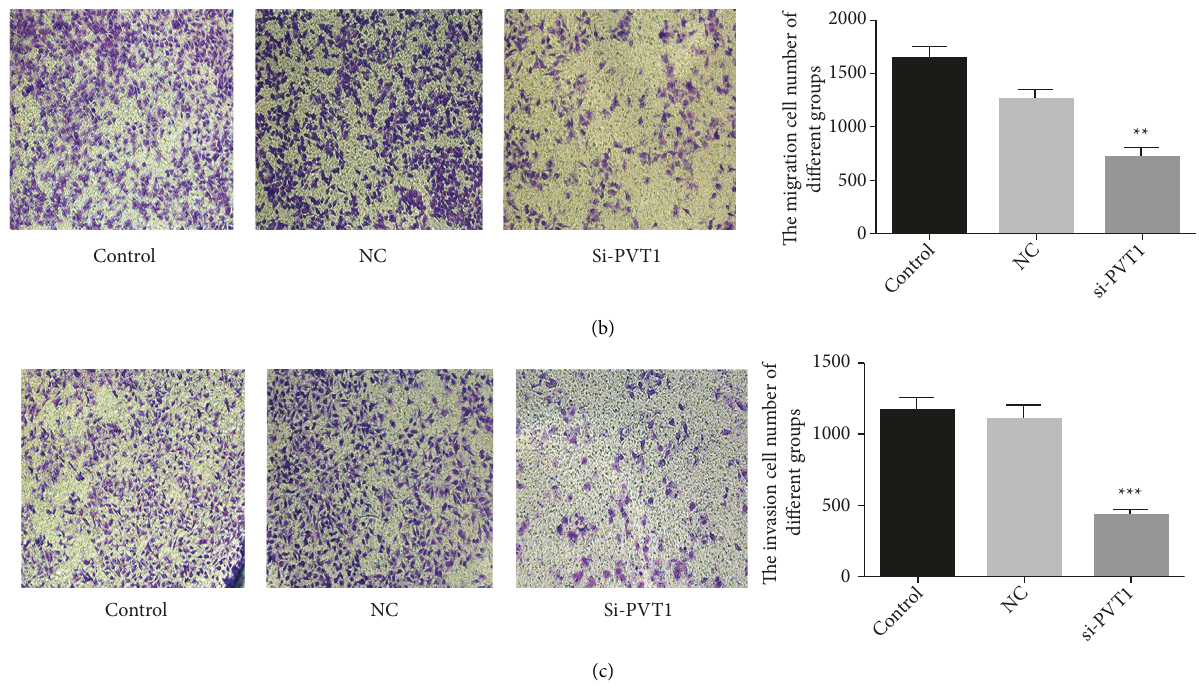
Figure 3: Knockdown of PVT1 inhibits tumor cell migration and invasion of MKN-45 cells in vitro. (a) The cell migration ability of different groups of cells studied by the wound-healing assay, showing that knockdown of PVT1 inhibits tumor cell migration. (b) The cell migration ability of different groups evaluated by the Transwell assay, showing that knockdown of PVT1 inhibits tumor cell migration. (c) The cell invasion ability of different groups analyzed by Transwell assay with Matrigel, showing that knockdown of PVT1 inhibits tumor cell invasion.